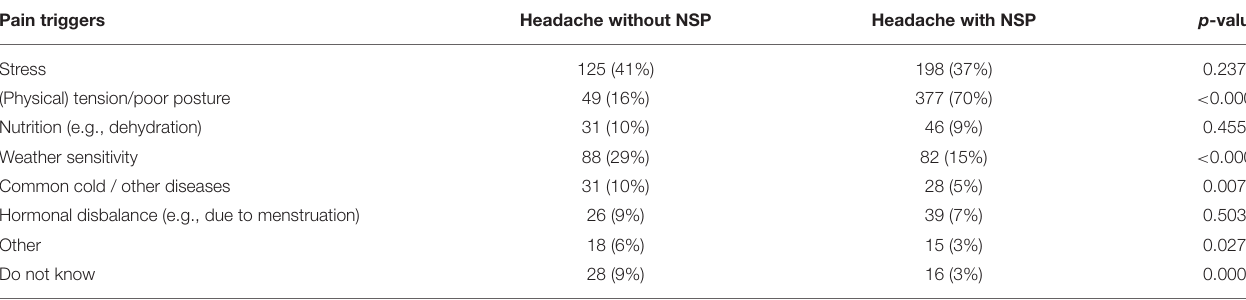
TABLE 2 | Perceived triggers for the assessed headache attack.